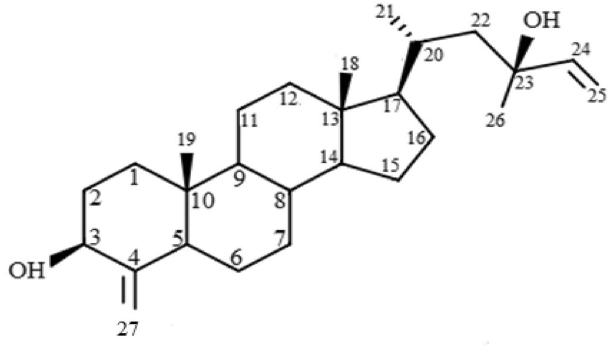
Figure 1. 5α-cholesta-4(27), 24-dien-3β, 23 β-diol isolated from the brittle star ( O. dentata